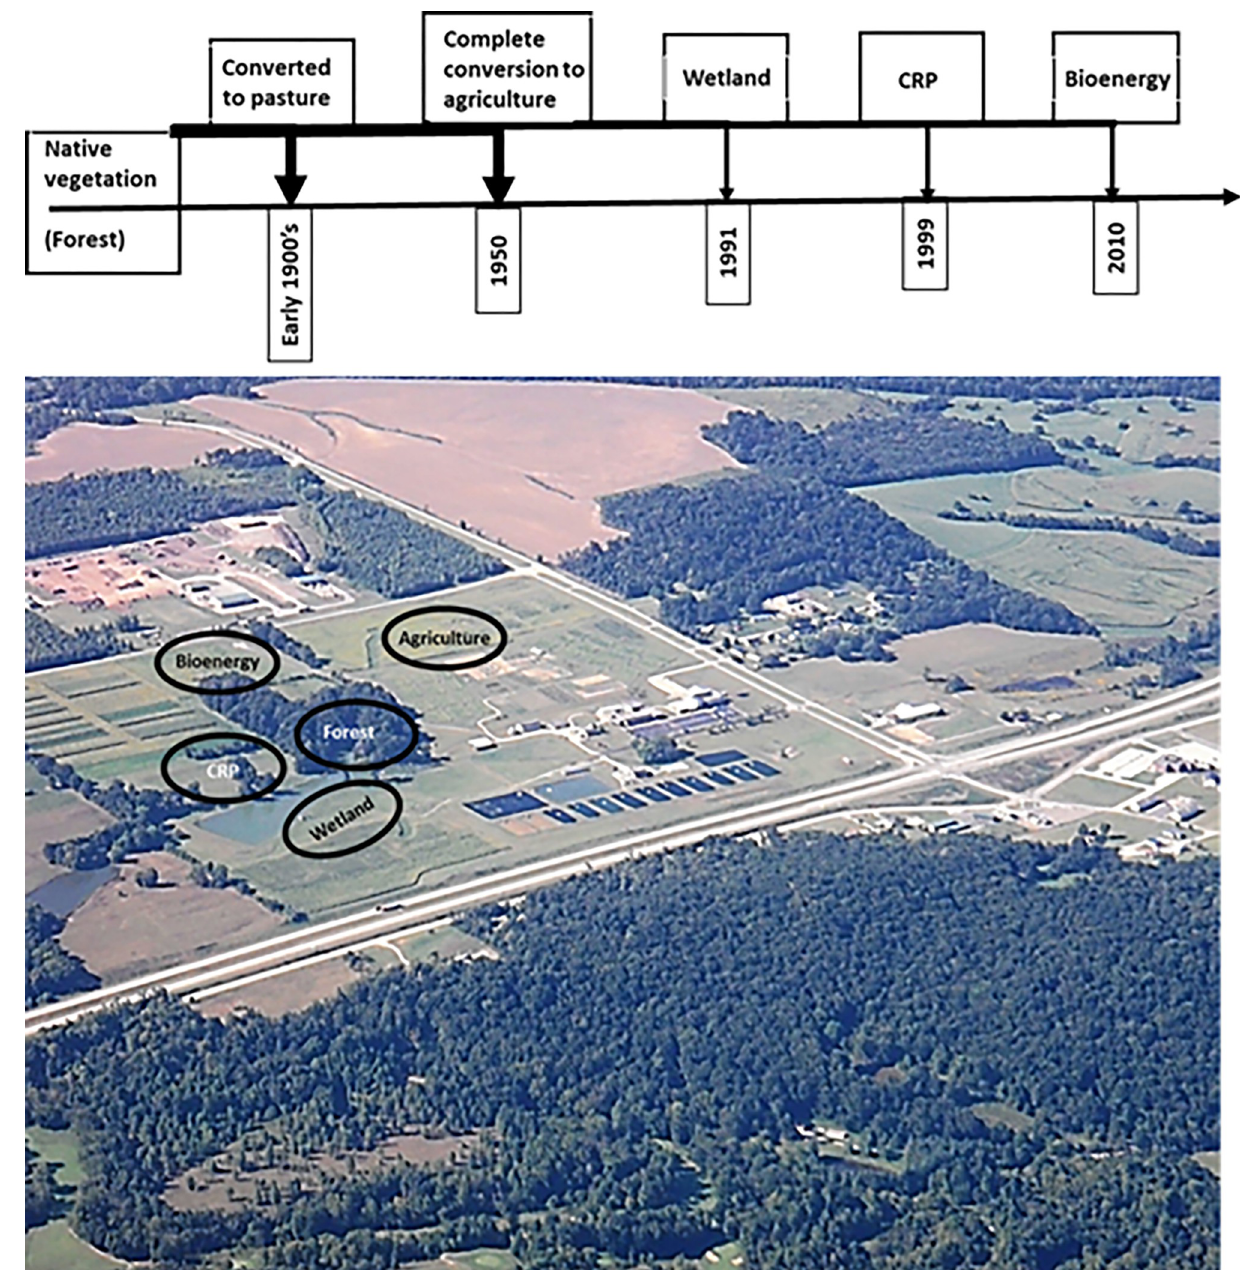
Fig 1. Chronology of the temporal land use diversity of the study area with sampling